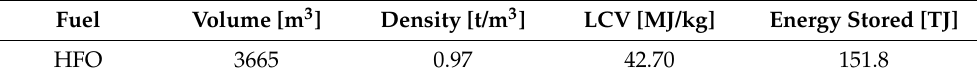
Table 3. Total amount of energy stored on board the reference ship.